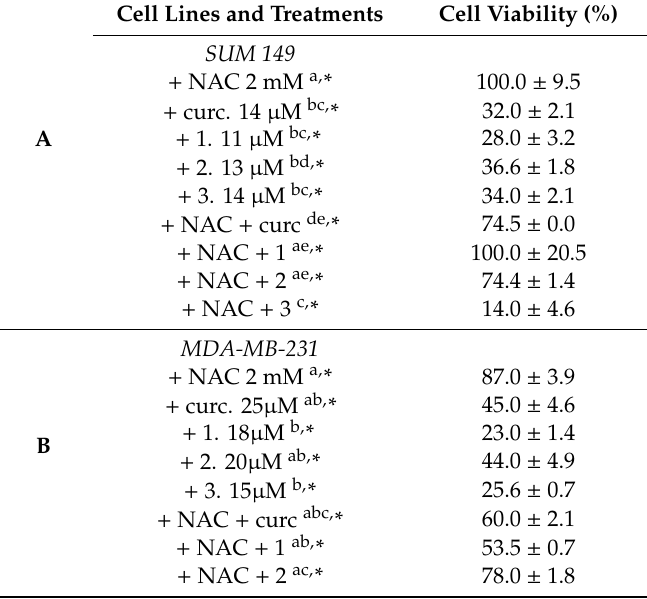
Table 2. Cell counting analysis in SUM 149 cells ( A ) and in MDA-MB-231 cells ( B ) after treatment with antioxidant NAC at 2mM before exposure to the curcumin and its analogues at the IC 50 values. Data are expressed as mean ± standard error (SE). Cell Lines and Treatments Cell Viability (%) SUM 149 + NAC 2 mM a, * A